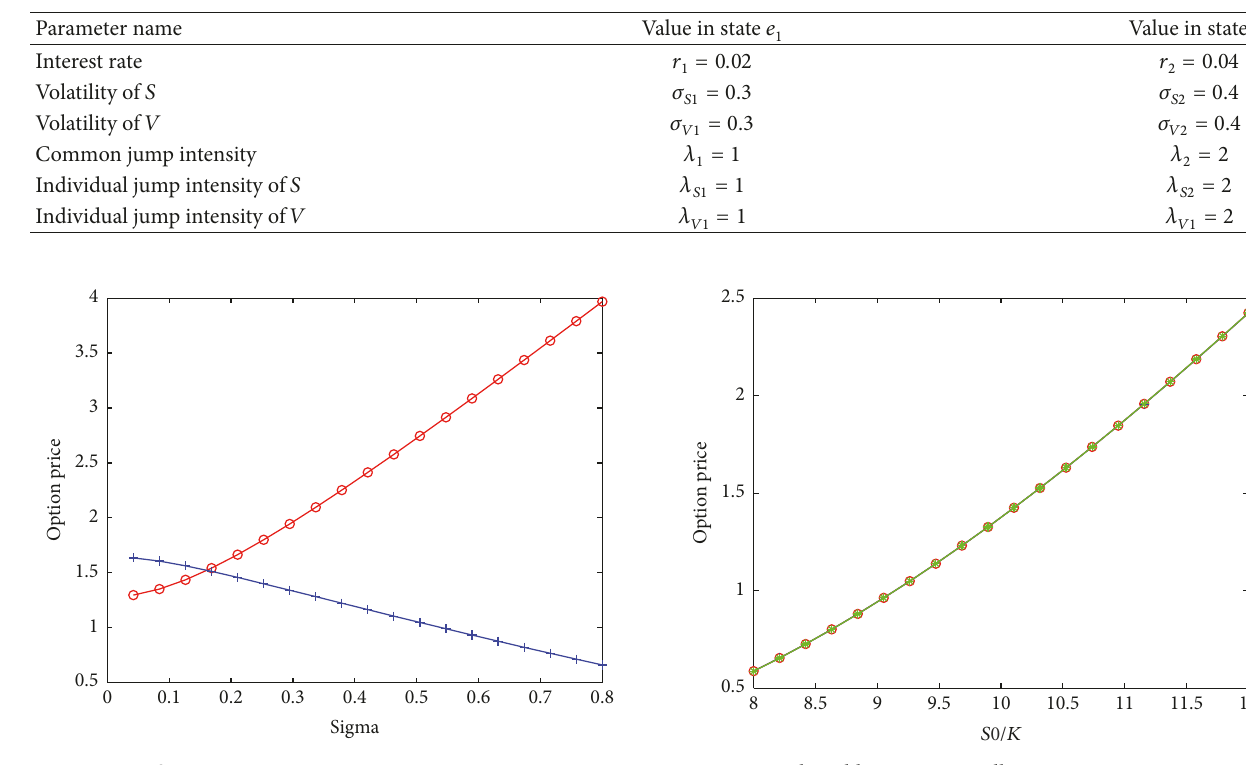
Figure 5: Vulnerable European call option price against spot-to- strikeratioforthreecaseswithparameters 𝜇 1 = 0, 𝜇 2 = 0, 𝜎 1 = 0.1 , and 𝜎 2 = 0.1 .